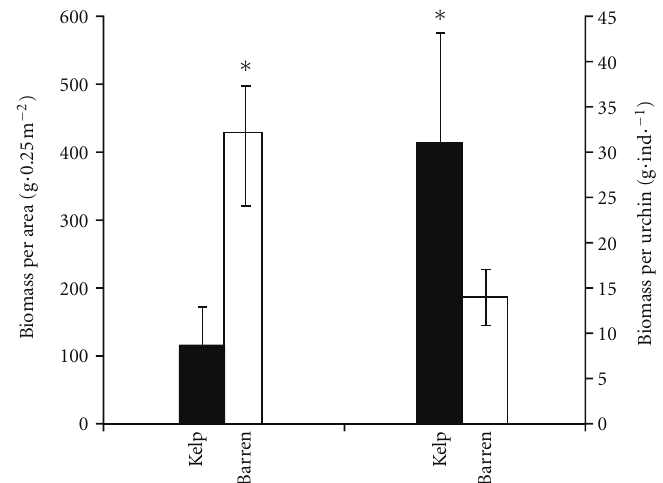
Figure 3: Sea urchin biomass per unit area and biomass per individual urchin from remnant kelp forest and urchin barren communities throughout the central and western Aleutian Islands. Significant di ff erences at P ≤ 0 . 05 level are indicated by ( ∗ ).